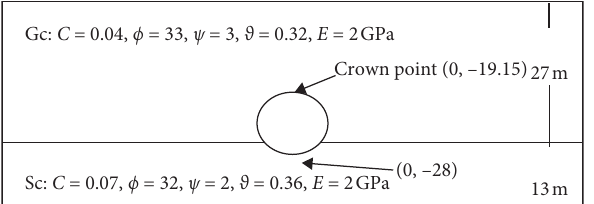
Gc: C = 0.04, ϕ = 33, ψ = 3, ϑ = 0.32, E = 2GPa